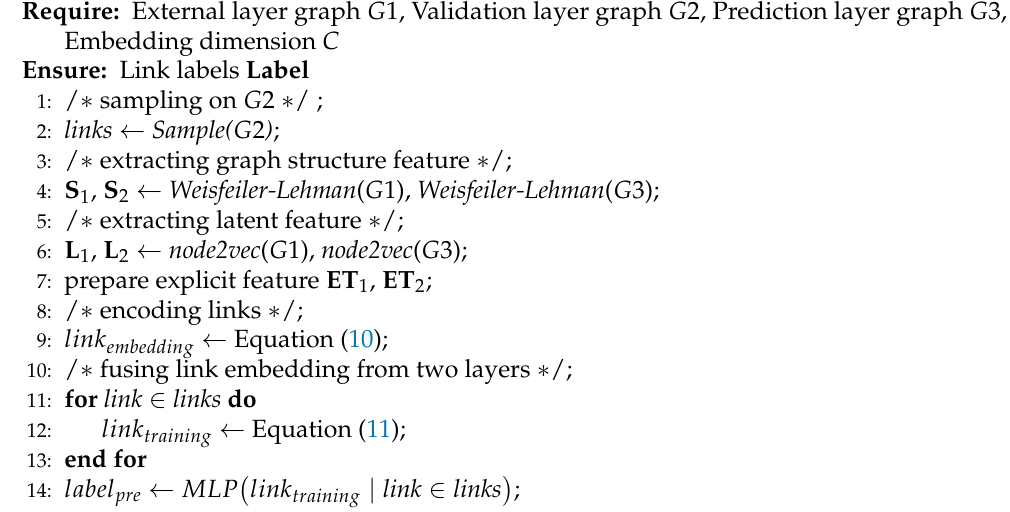
Algorithm 1 Link Prediction for Social Multiplex